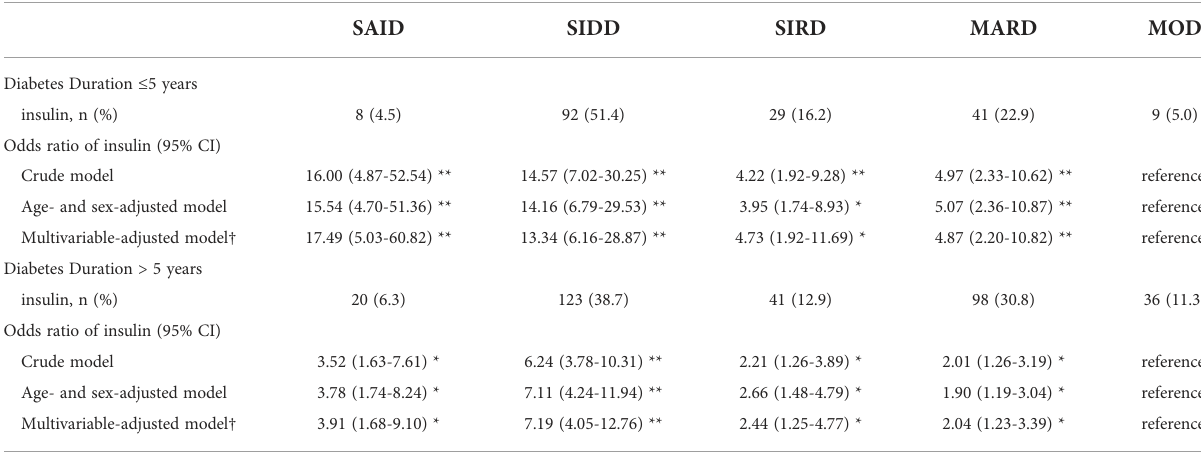
TABLE 3 Odds ratio of insulin (vs diet only or non-insulin hypoglycemic agents) for each diabetes subgroup. Diabetes subgroup